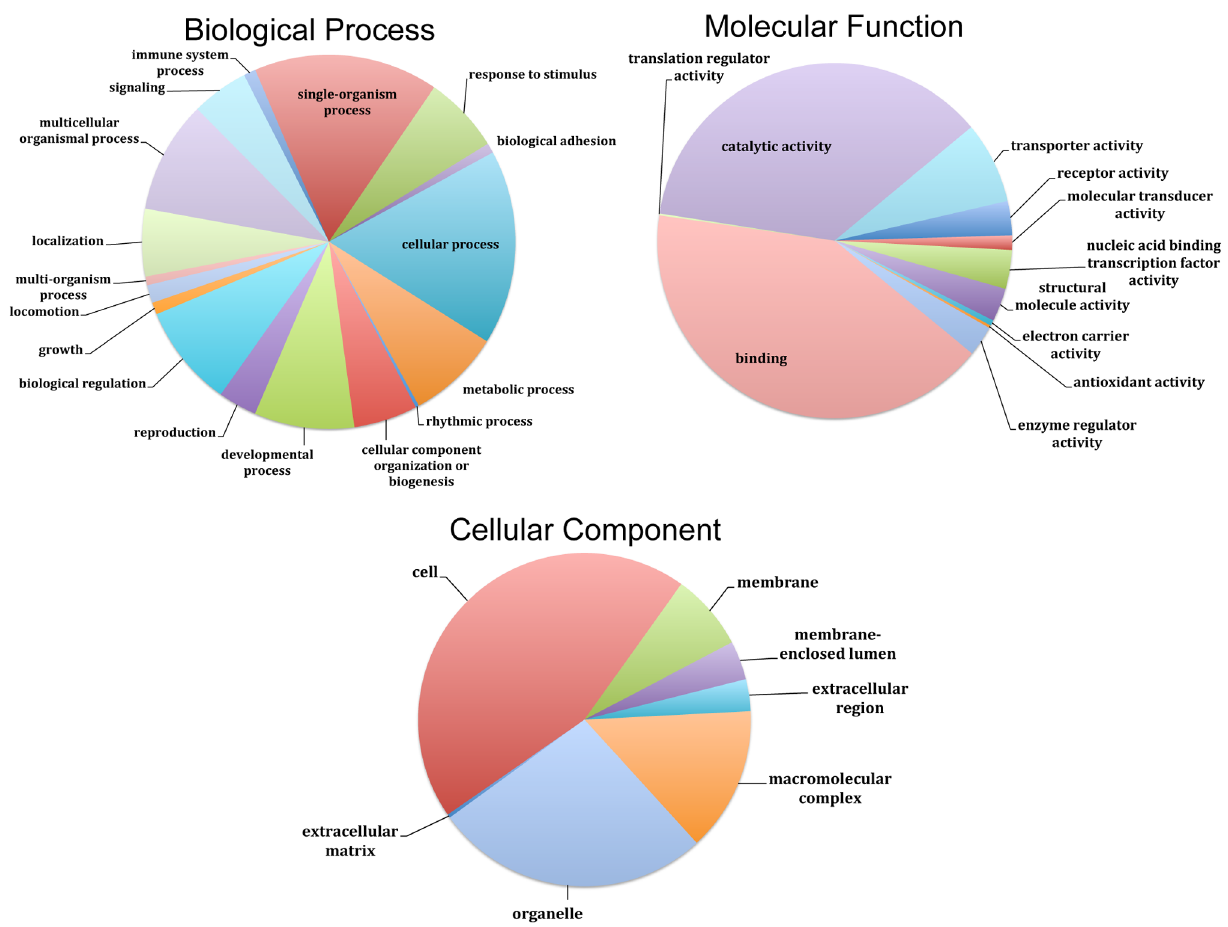
Figure 3. GO classification of the adult female midge unigene set. Classification and functional distrubuion of the 19,041 unigenes of the C. sonorensis transcriptome according to the 3 major classifications of the Gene Ontology: Biological Process, Molecular Function, and Cellular Component.